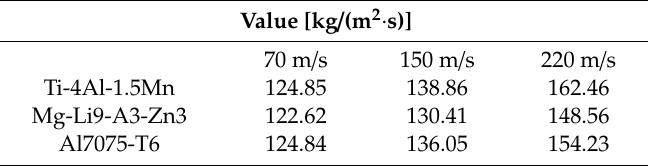
Figure 10. Erosion ratios of three materials at different angles of attack.